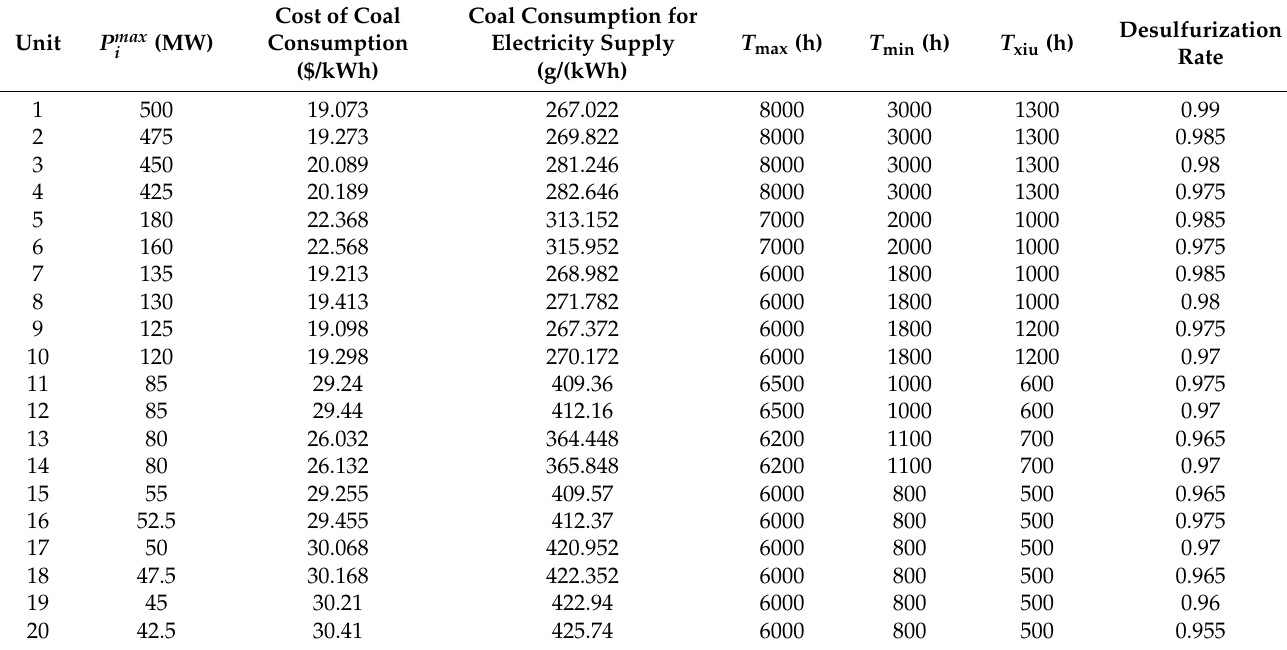
Table A1. Unit s’ operation